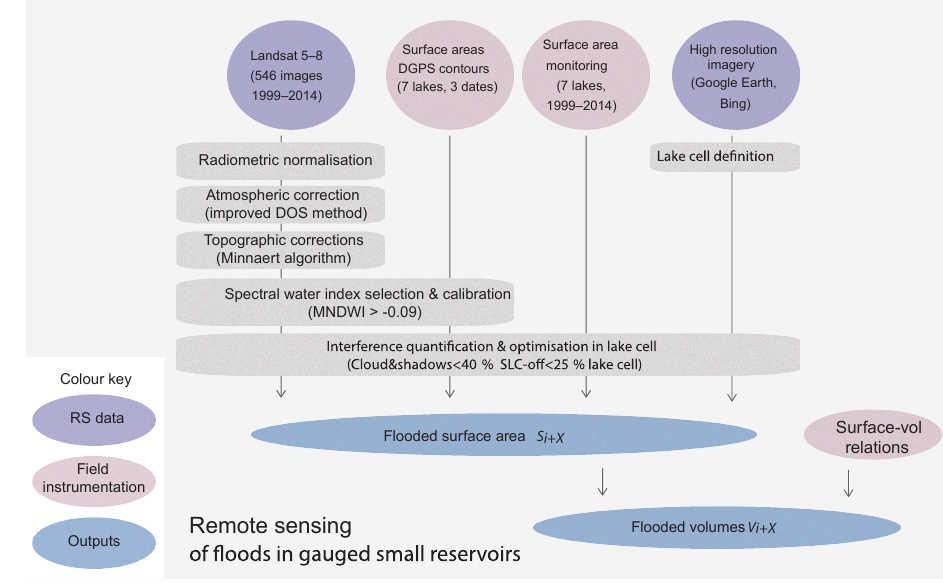
Figure 4. Chain of treatments applied to the 546 Landsat (TM, ETM + , and OLI)